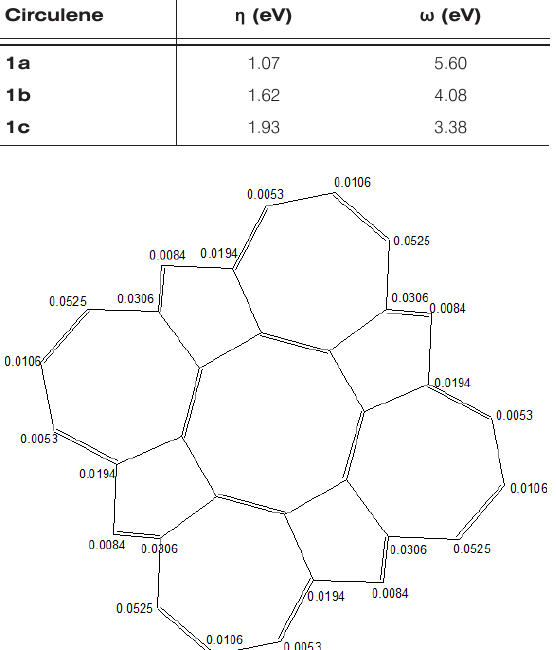
Figure 4. Fukui function (for an electrophilic attack, f + ) in circulene 1a (B3LYP/6-311G(d,p).